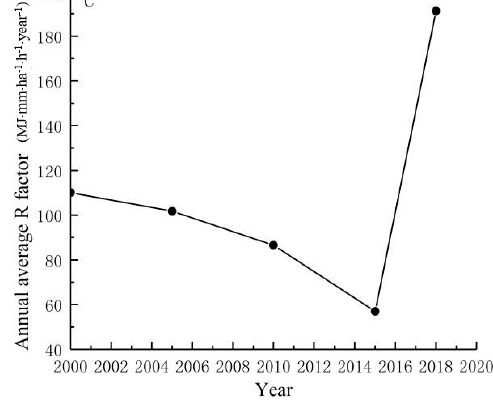
Figure 8. Time variation of annual average soil erosion modulus ( A ), annual average maximum synthesis values of normalized difference vegetation index (NDVI) ( B ) and annual average R factor( C ) in the Taohe River Basin.